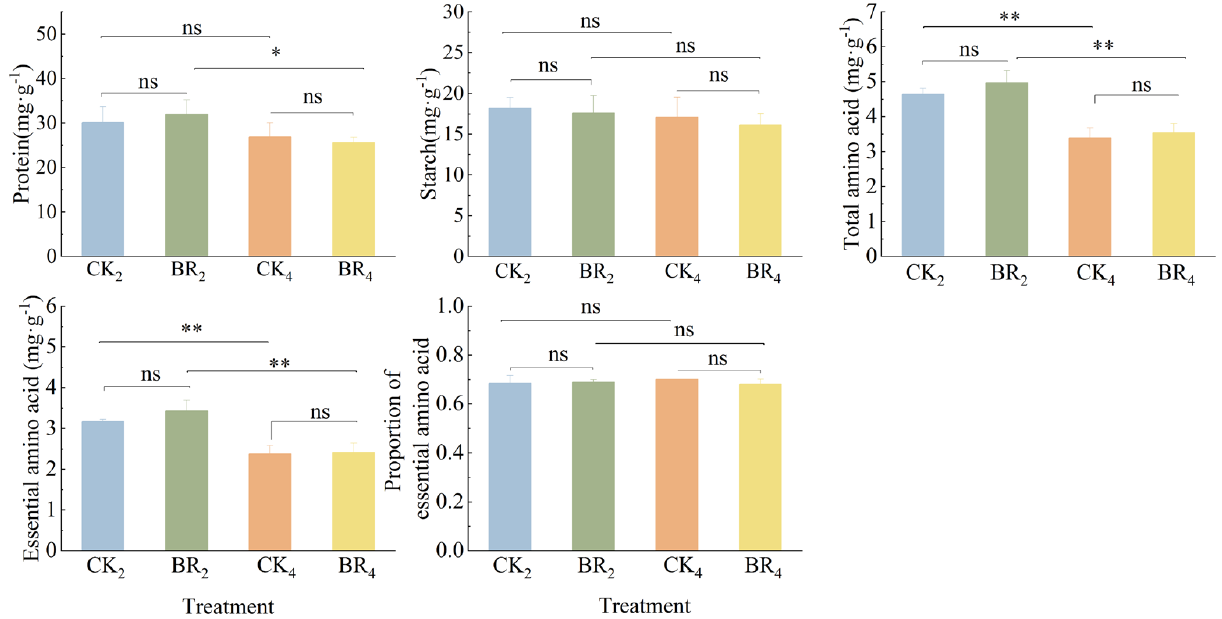
Figure 3. Nutritional quality of Ph. violascens shoots after sheath blade removal. CK 2 : natural growth after 2 d; BR 2 : sheath blade removal after 2 d; CK 4 : natural growth after 4 d; BR 4 : sheath blade re- moval after 4 d; ns: p > 0.05; *: p < 0.05; **: p < 0.01.